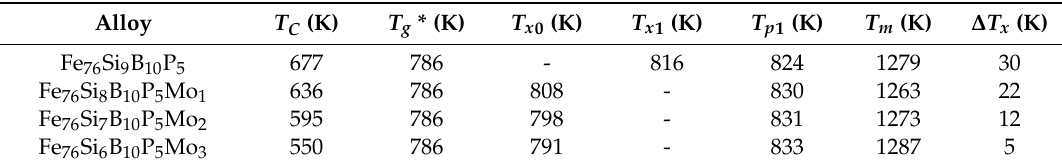
Figure 3. MDSC curves of the as-spun Fe 76 Si 9 − x B 10 P 5 Mo x ( x = 0, 1, 2 and 3) ribbons with a heating rate of 5 K/min. Table 1. Summary of thermal properties of the as-prepared Fe 76 Si 9 − x B 10 P 5 Mo x ( x = 0, 1, 2 and 3) glassy alloys determined from the DSC curves at a heating rate of 20 K/min. T c , T x , T p1 , and T m are the Curie temperature, the glass transition temperature, the onset temperature of crystallization, the first crystallization peak, the liquidus temperature and the melting point, respectively. ( Δ T x = T x – T g ).